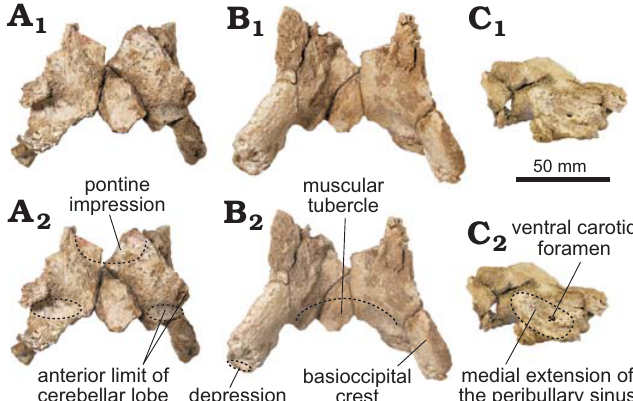
Fig. 3. The portion of basioccipital of the holotype of the platanistoid dolphin Aondelphis talen gen. et sp. nov. (MPEF-PV 517) from the early Miocene Gaiman Formation, Bryn Gwyn, Patagonia, Argentina; in dor- sal ( A ), ventral ( B ), and lateral ( C ) views. Dashed lines indicate specific structures. Photographs (A 1 –C 1 ), photographs with explanations (A 2 –C 2